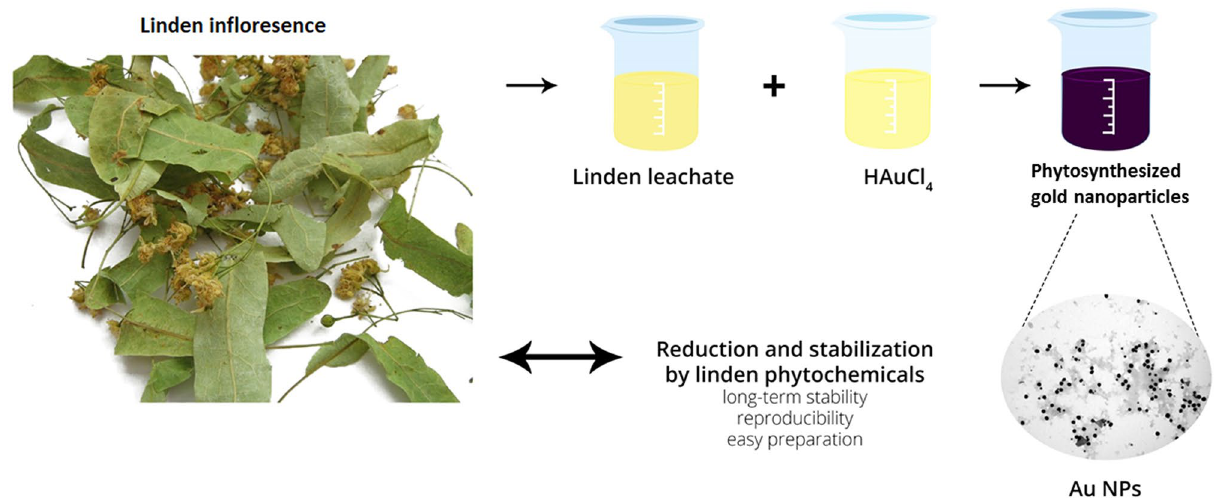
Figure 1. Batch phytosynthesis of Au NPs using linden bracts